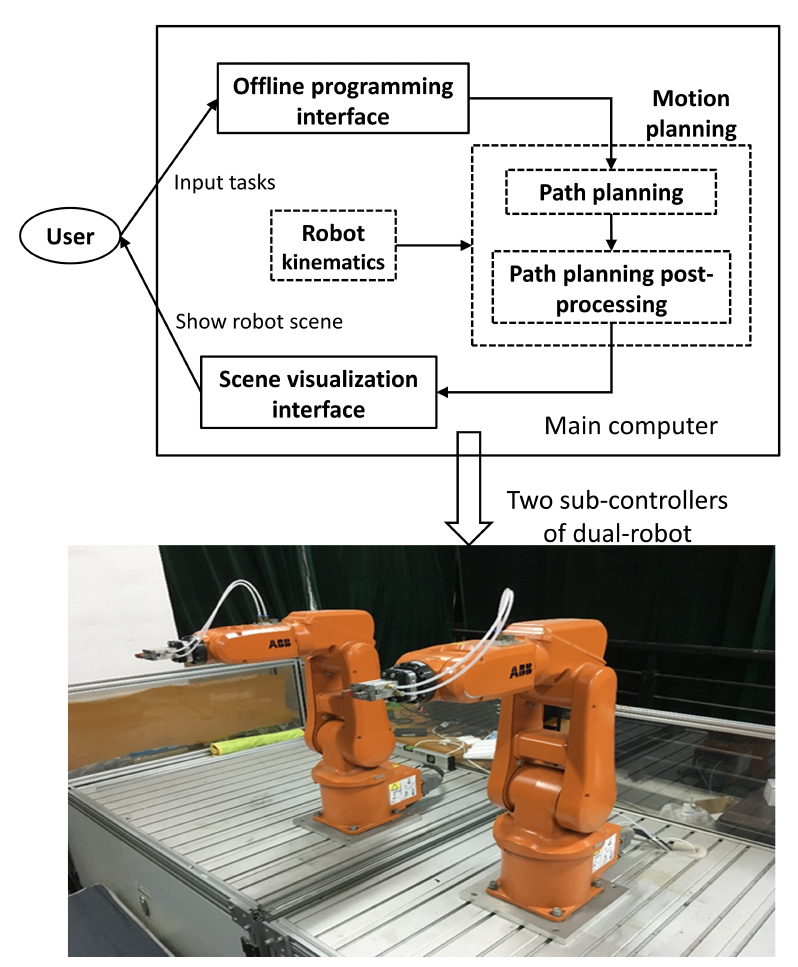
Figure 1. Dual-robot collaborative assembly